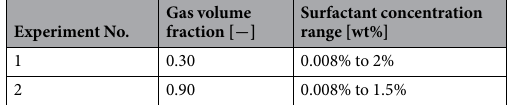
Table 2. Summary of the surfactant-variation